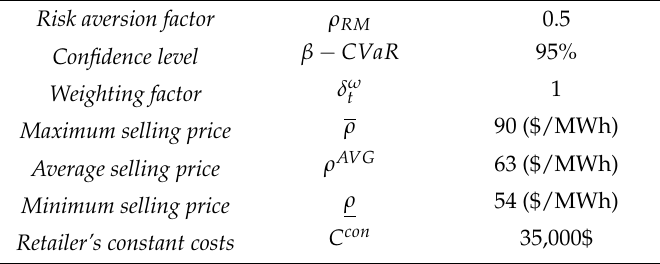
Table 9. Supplementary input parameter.